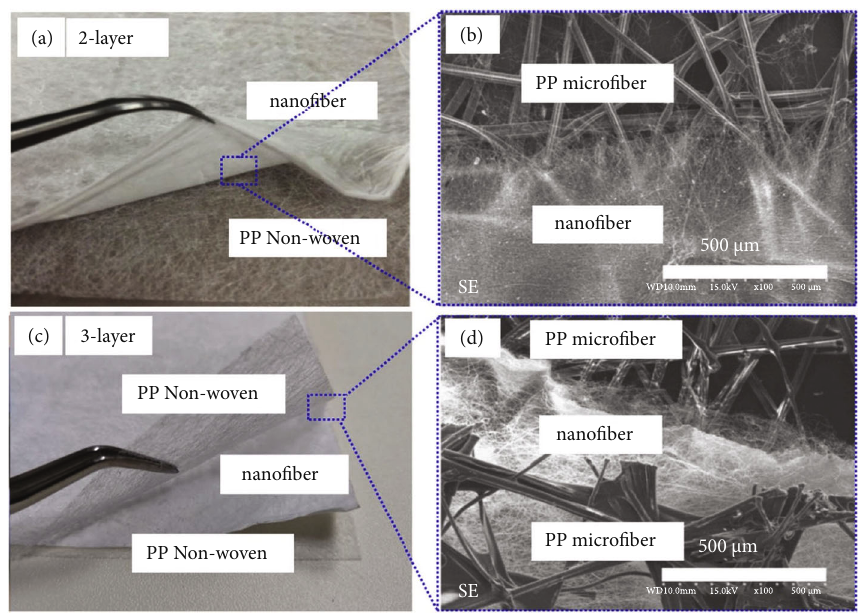
Figure 7: TiO -based nano fi bers membrane for face masks 2